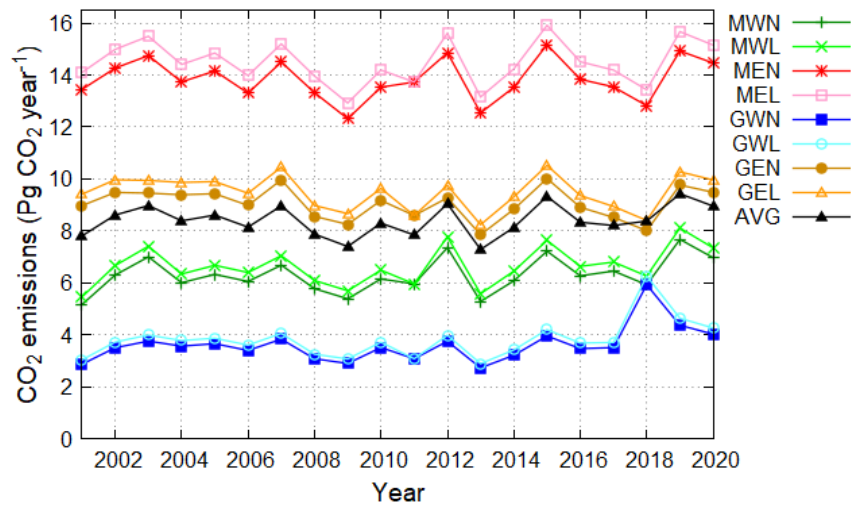
Figure 3. Interannual variation in CO 2 emissions of eight inventories between 2001 and 2020. The datasets used for each inventory are shown in Table 2. AVG denotes the average of the eight inventories.